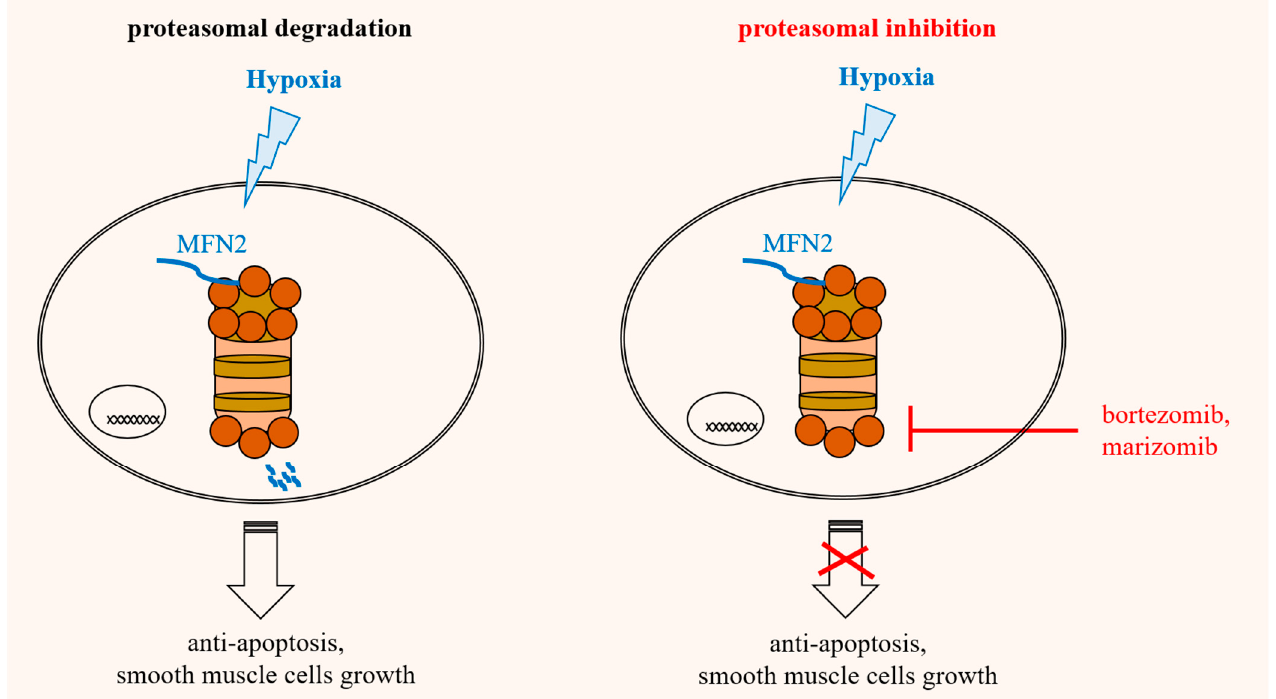
Figure 5. Schematic diagram of proteasome inhibitors restoring the physical hypoxia-inhibited MFN2 expression, inducing apoptosis, and inhibiting the hypoxia- induced proliferation in HPASMCs. The left image shows that hypoxia increases the proteasomal degradation of MFN2, inhibiting apoptosis and promoting cell growth. The right image shows that bortezomib and marizomib blocked the activity of the proteasome, inhibiting the ability of anti-apoptosis and cell growth.